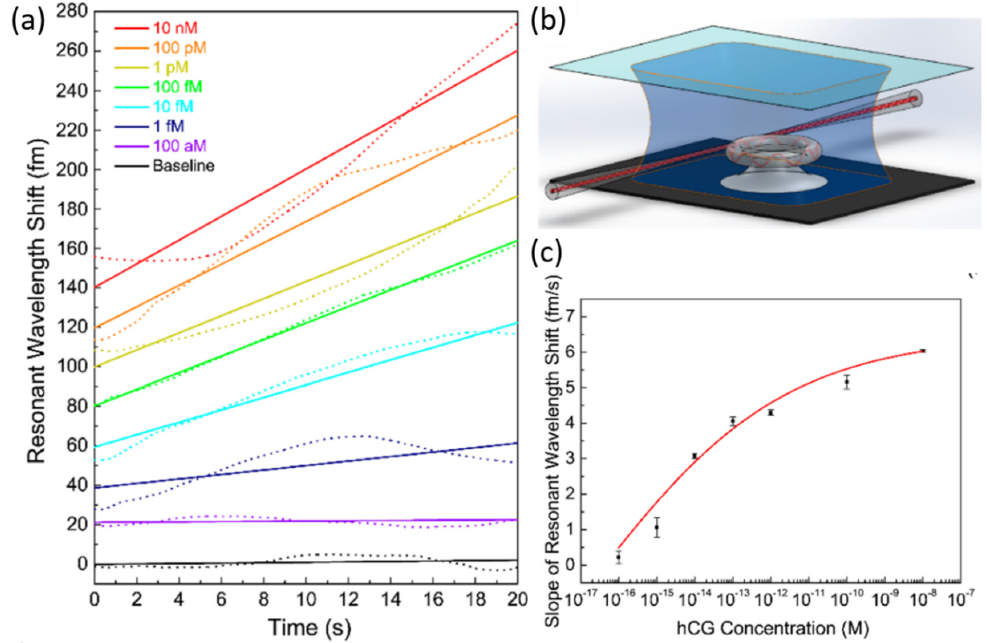
Figure 28. ( a ) Corresponding wavelength shifts over 20 s for concentrations of hCG, ranging from 100 aM to 10 nM. ( b ) Schematic of the microtoroid chamber and optical fiber. ( c ) concentration curve resulting from ( a ). Reproduced from ref. [121] with permission from ACS Publications.